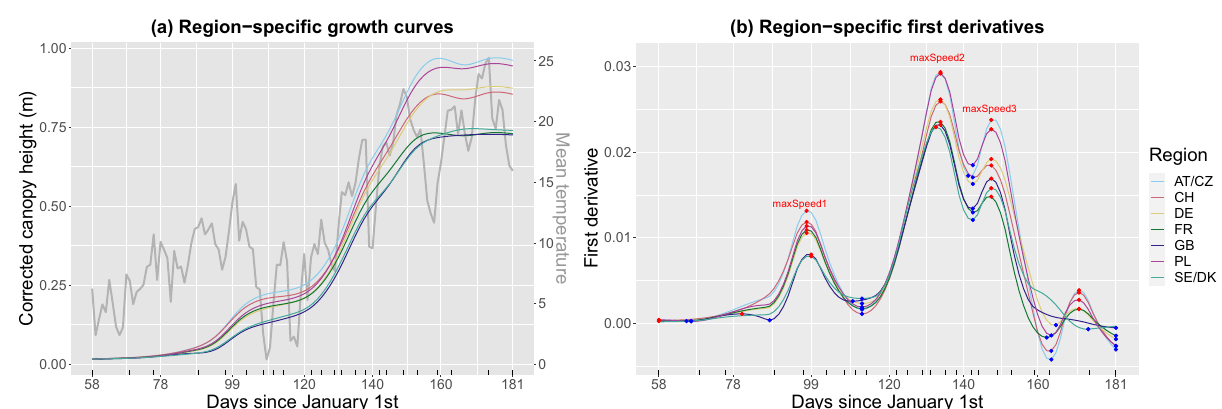
Figure 6. Results of the second stage of analysis for the ETH field phenotyping platform: ( a ) estimated region (orange) and genotype-specific (blue) growth curves, ( b ) estimated region (orange) and genotype-specific (blue) first-order derivatives, and ( c ) estimated genotype-specific deviations. In ( a ) and ( b ) the orange shaded areas denote 95% pointwise confidence intervals at the region level. AT/CZ: Austria/Czechia; CH: Switzerland; DE: Germany; FR: France; GB: Great Britain; PL: Poland; SE/DK: Sweden/Denmark.